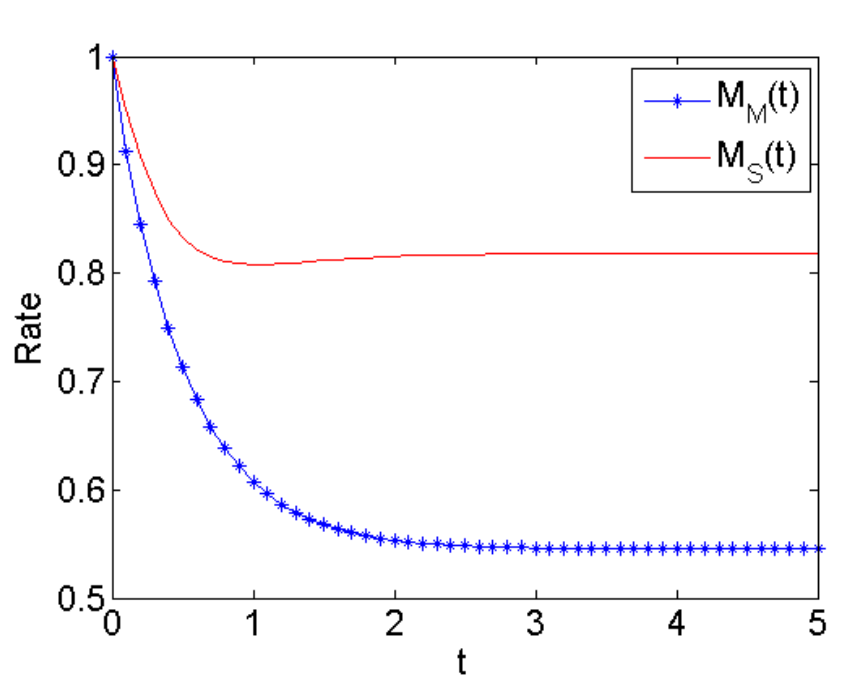
Figure 5. The transient-state malfunction rate of the machine ( M M ( t )) and the server ( M S ( t )) for λ = 1, µ = 2, ξ 1 = 1, ξ 2 = 1.5, η 1 = 2 and η 2 =